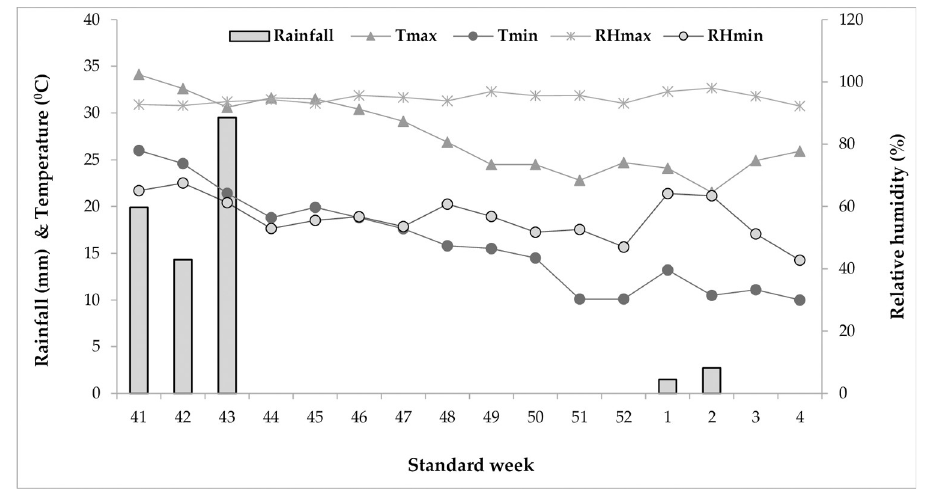
Fig 1. Climatological parameters during the cropping period (average weekly data of